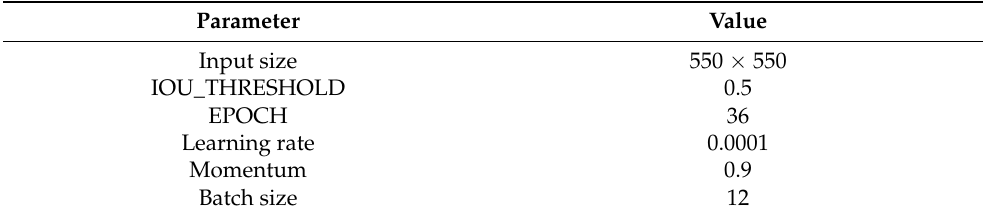
Table 1. Parameters of YOLACT++ for model training.